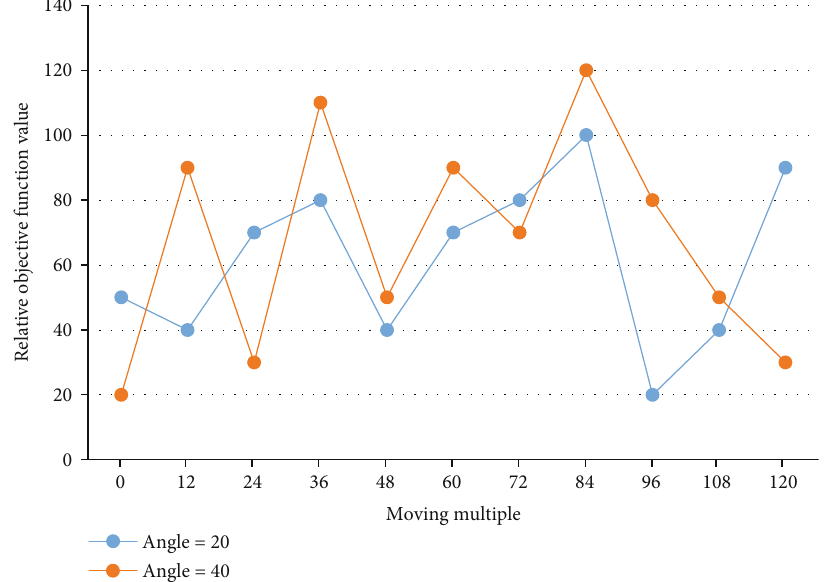
Figure 5: Registration results in the vertical